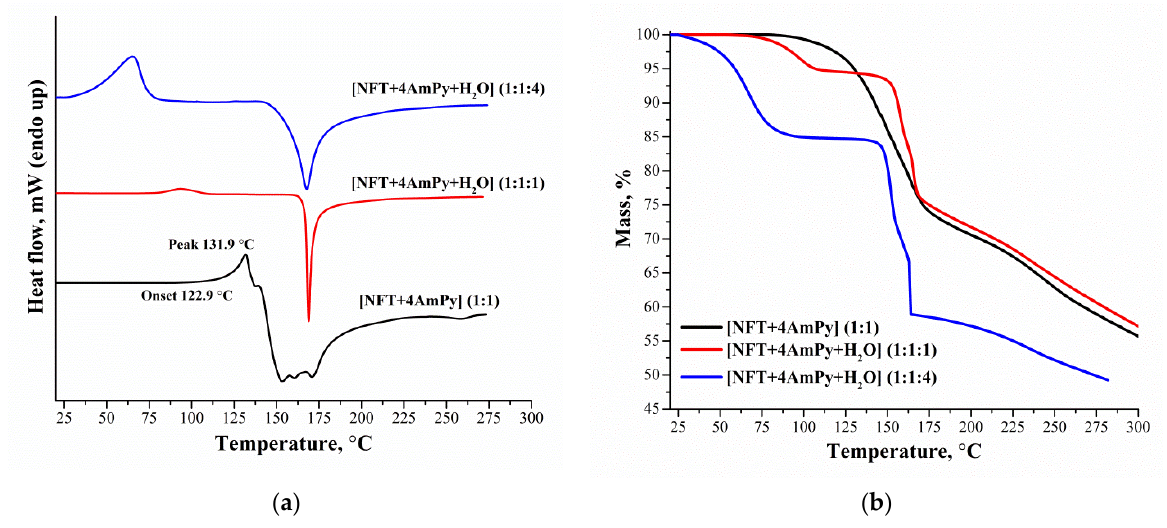
Figure 6. ( a ) DSC and ( b ) TG curves of the NFT multicomponent solids. The DSC and TG curves obtained for the [NFT+4AmPy] salt (1:1) confirmed that this Table 1. Physicochemical characteristics of dehydration for the NFT salt hydrates. phase was an anhydrous/unsolvated form of the NFT and 4AmPy salt. The DSC curve revealed a single endothermic peak with T onset = 122.9 ± 0.2 °C ( ∆ H fus = 57.2 ± 0.5 J·g − 1 ), T onset , ◦ dehydr indicating the melting of salt. An exothermic event immediately after the endothermic peak was associated with sample decomposition at temperatures above 140 ° С . According